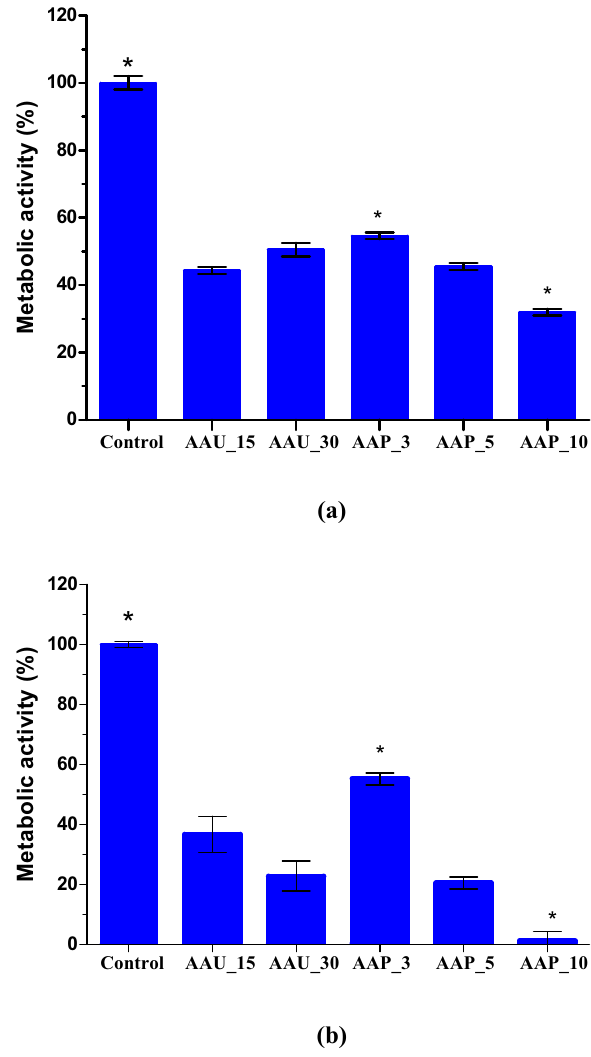
Figure 4. Effect of airborne acoustic ultrasound and atmospheric air plasma treatment on metabolic activity of 96 h ( a ) E. coli and ( b ) L. innocua biofilms. Error bars indicate standard deviation (n = 4). Significant differences between different treatments are marked by asterisks (P < 0.05; One-way ANOVA test and Tukey multiple comparison post hoc test). Graphs were generated using GraphPad Prism version 5.0 (GraphPad Software, San Diego, California USA, http://www.graph pad.com). AAU_15: airborne acoustic ultrasound treatment for 15 min; AAU_30: airborne acoustic ultrasound treatment for 30 min; AAP_3: atmospheric air plasma treatment for 3 min; AAP_5: atmospheric air plasma treatment for 5 min; AAP_10: atmospheric air plasma treatment for 10